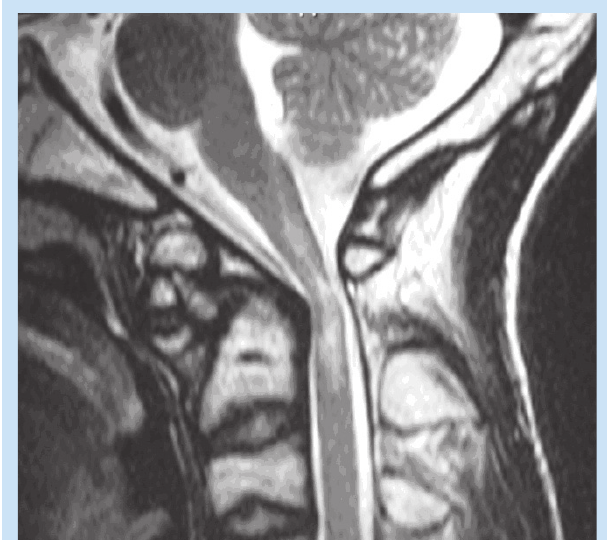
Fig. 5. Sagittal T2-weighted MR image demonstrating abnormal high signal in the cord which is kinked at the upper cervical level. The markedly narrowed spinal canal and anterior CSF effacement is well